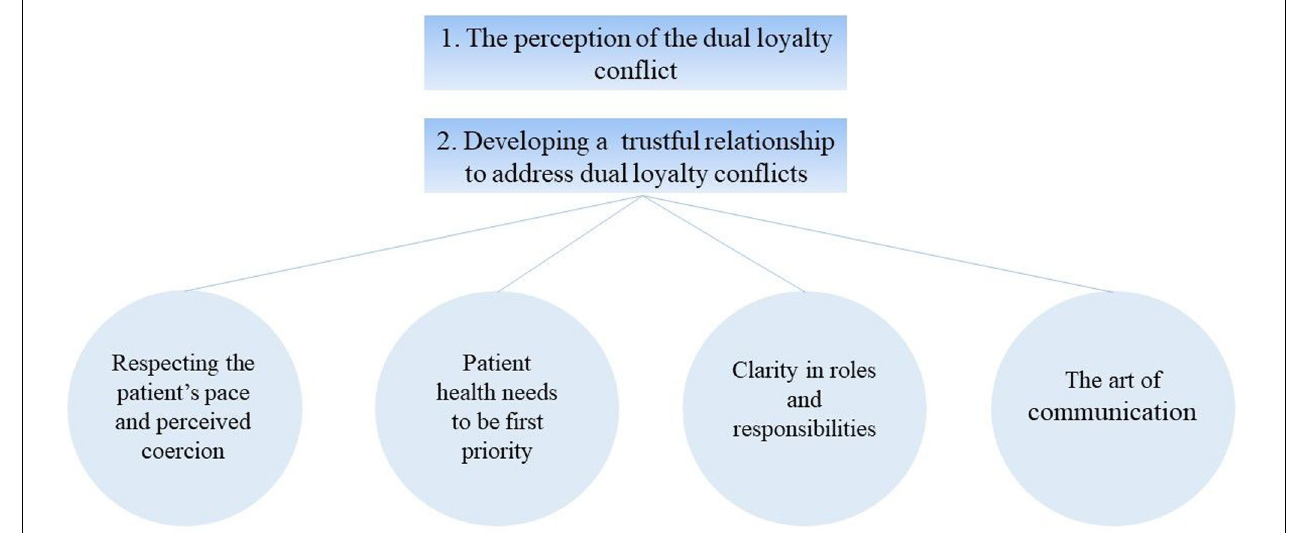
FIGURE 1 | Main topics on the patients’ perception on their psychotherapist’s dual loyalty